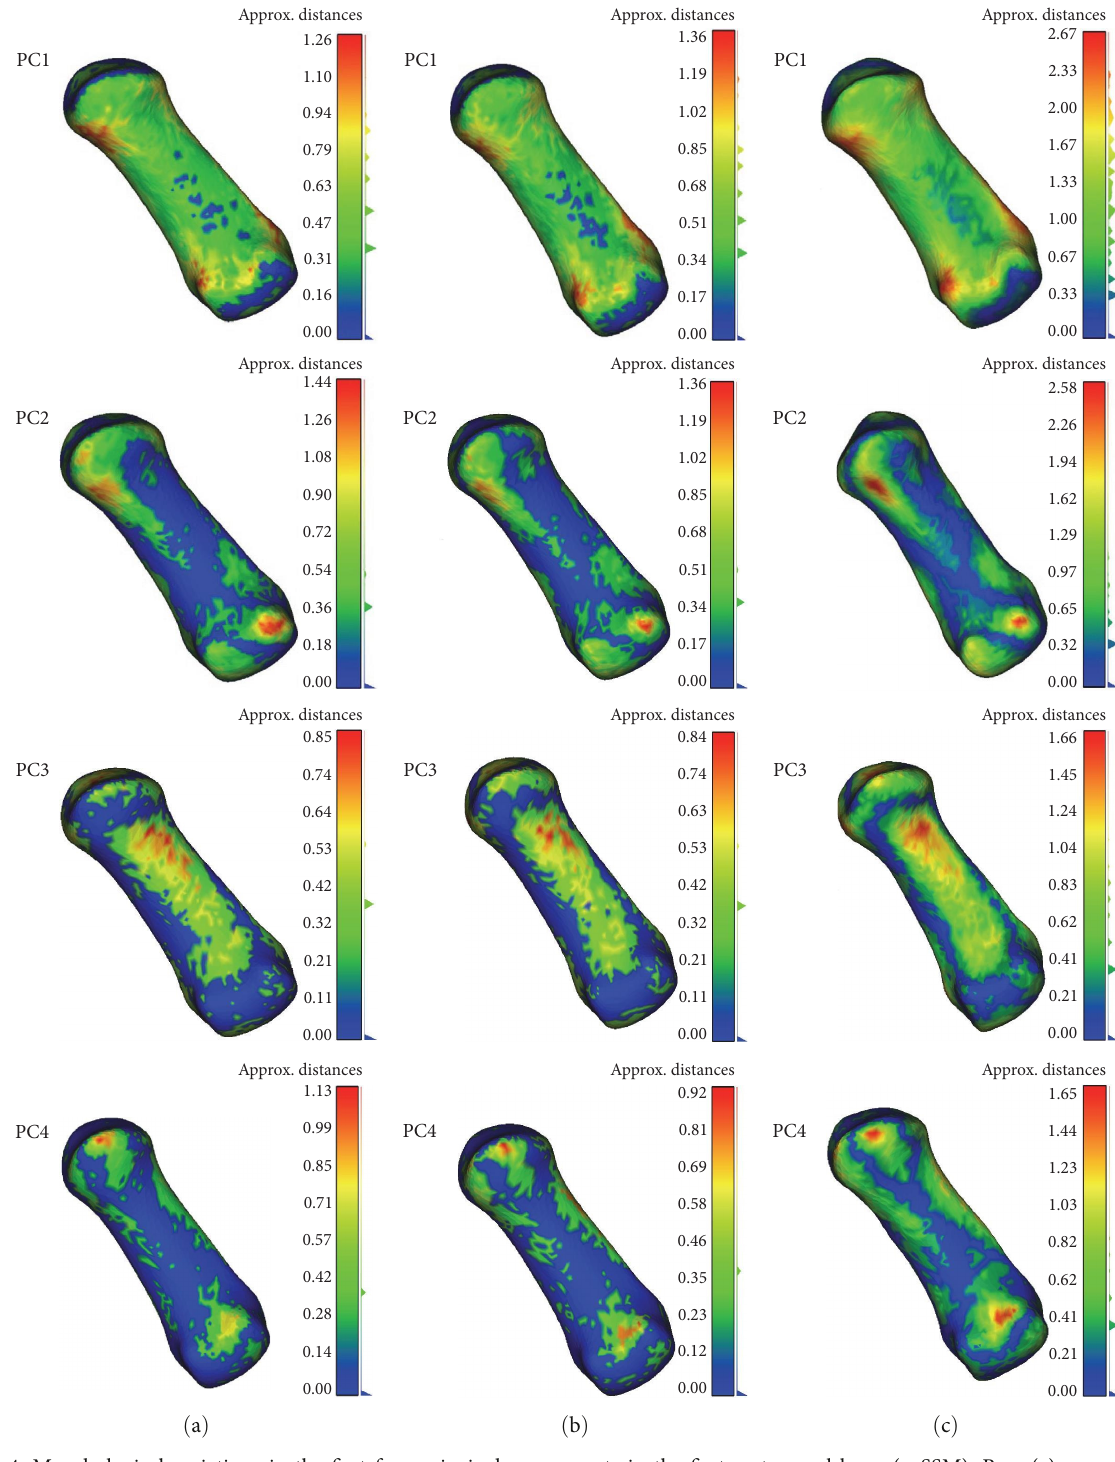
F IGURE 4: Morphological variations in the fi rst four principal components in the fi rst metacarpal bone (nrSSM). Row (a) represents the distance map of the mean model and − 2SD model. Row (b) represents the distance map of the mean model and + 2SD model. Row (c) represents the distance map of the − 2SD model and the + 2SD